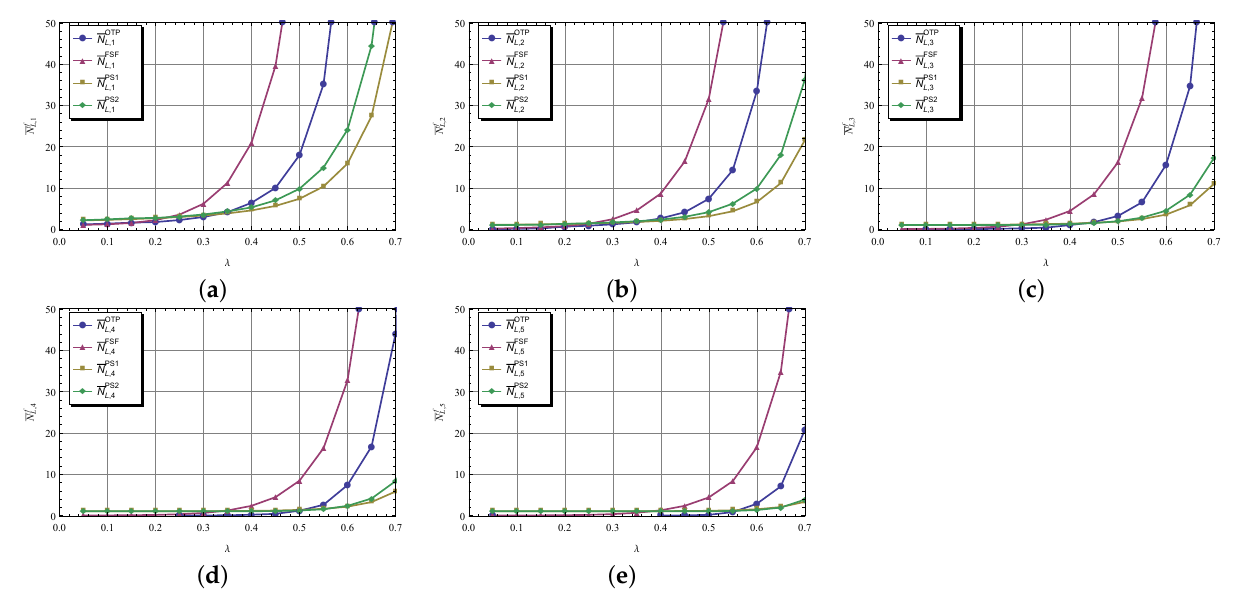
Figure 5. The mean number of customers ¯ N L , k for k = 1, . . . ,5 respectively in ( a – e ) versus λ .